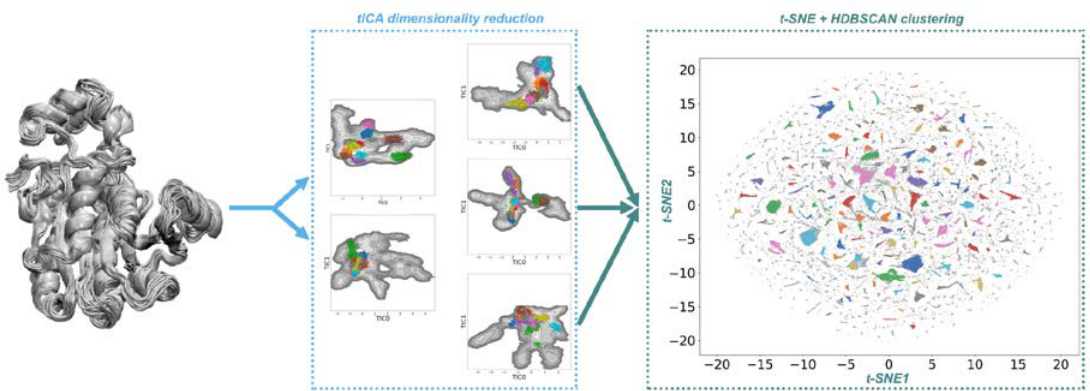
Figure 2. Computational protocol used to reconstruct the conformational landscapes of the different HHDH subclasses. It is based on a two-step process consisting of: first applying to the MD dataset the linear time-Independent Component Analysis (tICA) [35], followed by the application of the non-linear t-distributed Stochastic Neighbor Embedding (t-SNE) [33] method. In this fashion, the high dimensional MD dataset is reduced into a 2D space, that is subsequently clustered using HDBScan [37].